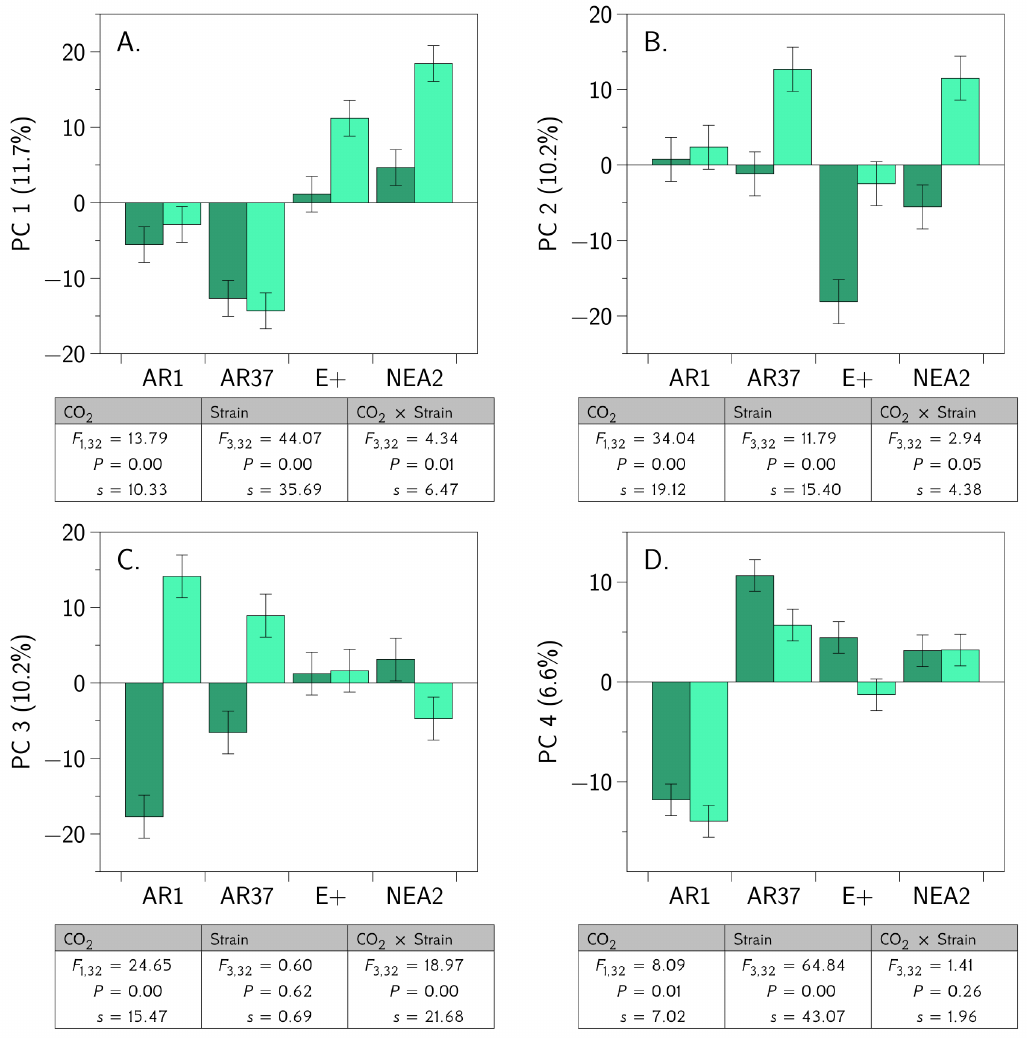
Figure 8. Integrated OMICs responses to CO 2 and endophyte strain. Throughout, the dark bars represent 400 ppm CO 2 , while the light bars denote 800 ppm CO 2 . Error bars depict the standard error of the mean. ( A ) principal component 1. ( B ) principal component 2. ( C ) principal component 3. ( D ) principal component 4. Below each graph are the results from the corresponding ANOVA. We also report the Shannon information transformation, s